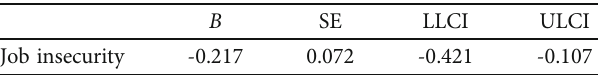
Table 5: Bootstrap indirect e ff ect of E-government policy on healthcare crises through Job